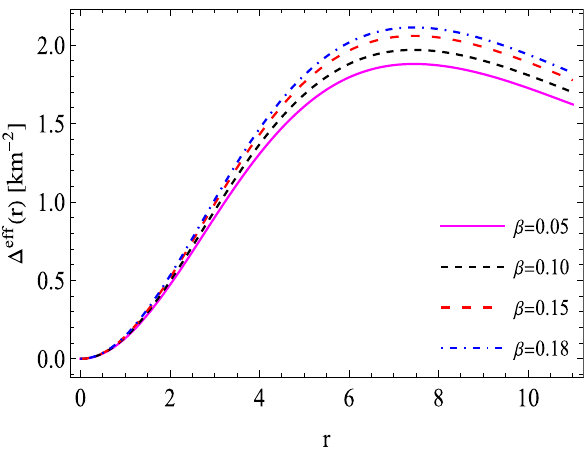
Fig. 5 The above figure shows the behavior of the effective anisotropy ( (cid:4) eff × 10 − 4 [ km − 2 ] ) with respect to r for different β